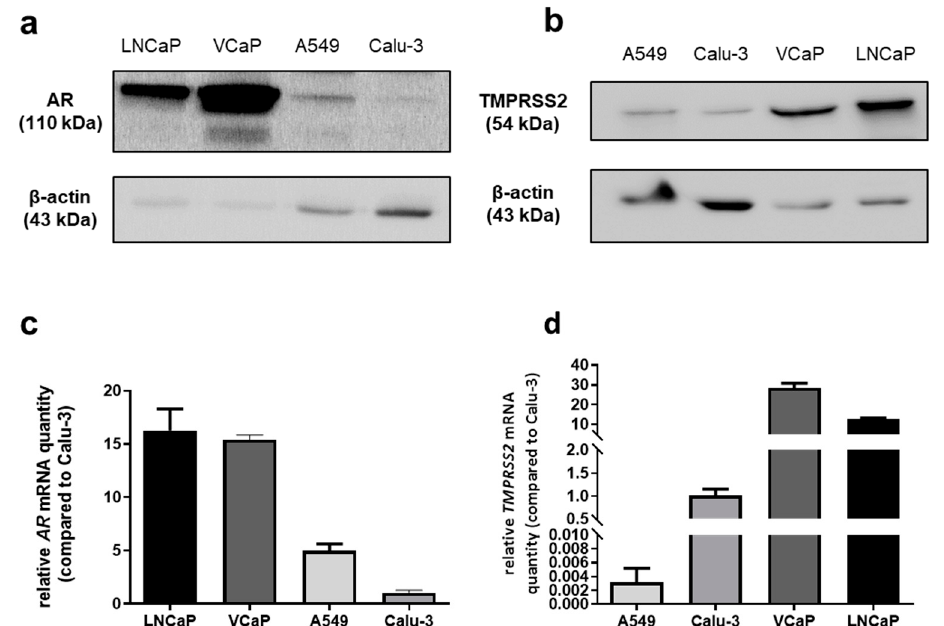
Figure 1. AR and TMPRSS2 protein and mRNA expressions in Calu-3 and A549 lung cells (LNCaP and VCaP PCa cell lines were used as positive controls). ( a ) Western blot analysis of AR and β -actin expression; ( b ) Western blot analysis of TMPRSS2 and β -actin expression; ( c , d ) mRNA expression levels of AR ( c ) and TMPRSS2 ( d ) as assessed by RT-qPCR. Results were normalized to RPLP0, then to mRNA quantities in Calu-3 cells. Relative quantities are expressed as mean ± SEM of three independent experiments.